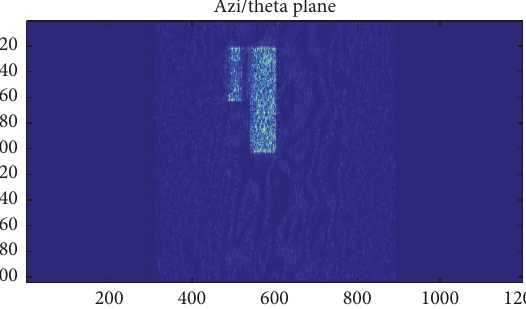
Figure 13: Azimuth-angle plane.